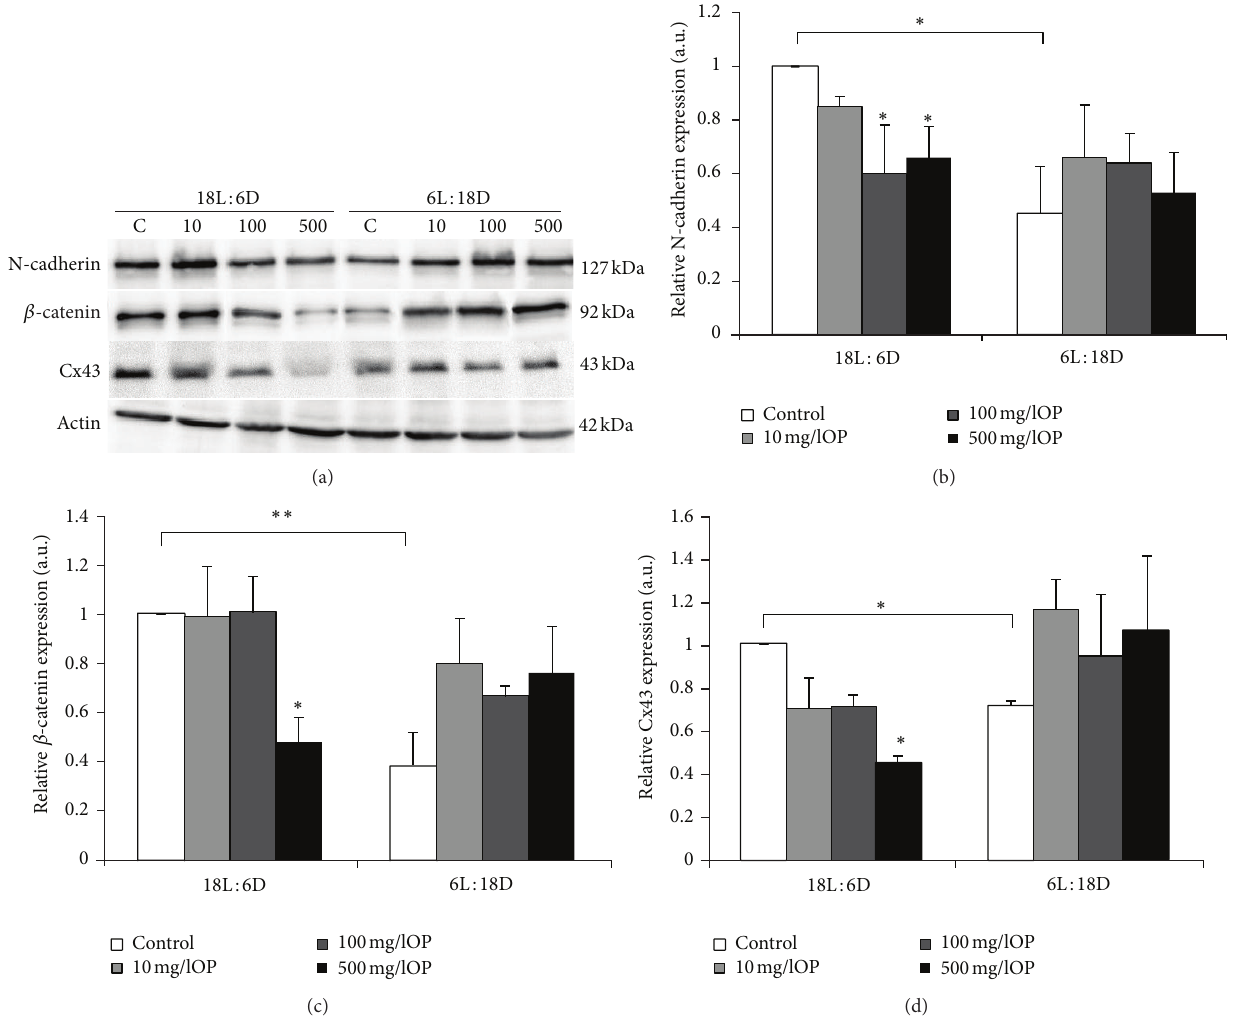
Figure 4: (a) Representative Western blot analysis of N-cadherin, 𝛽 -catenin, and connexin 43 protein expression levels in homogenates of testis explants from bank voles kept in either long light cycles (18L:6D; 𝑛 = 8 ) or short light cycles (6L: 18D; 𝑛 = 8 ). Explants were cultured in control medium (c) or in media containing 10, 100, or 500 mg/L 4- tert -octylphenol for 24 h. Anti- 𝛽 -actin labeling served as an internal protein loading control. (b)–(d) The relative amount of N-cadherin (b), 𝛽 -catenin (c), and connexin 43 (d) proteins normalized to 𝛽 -actin. Data obtained from three separate analyses is expressed as mean ± SD. Significant differences from control values are denoted as ∗ 𝑃 < 0.05 and ∗∗ 𝑃 < 0.01